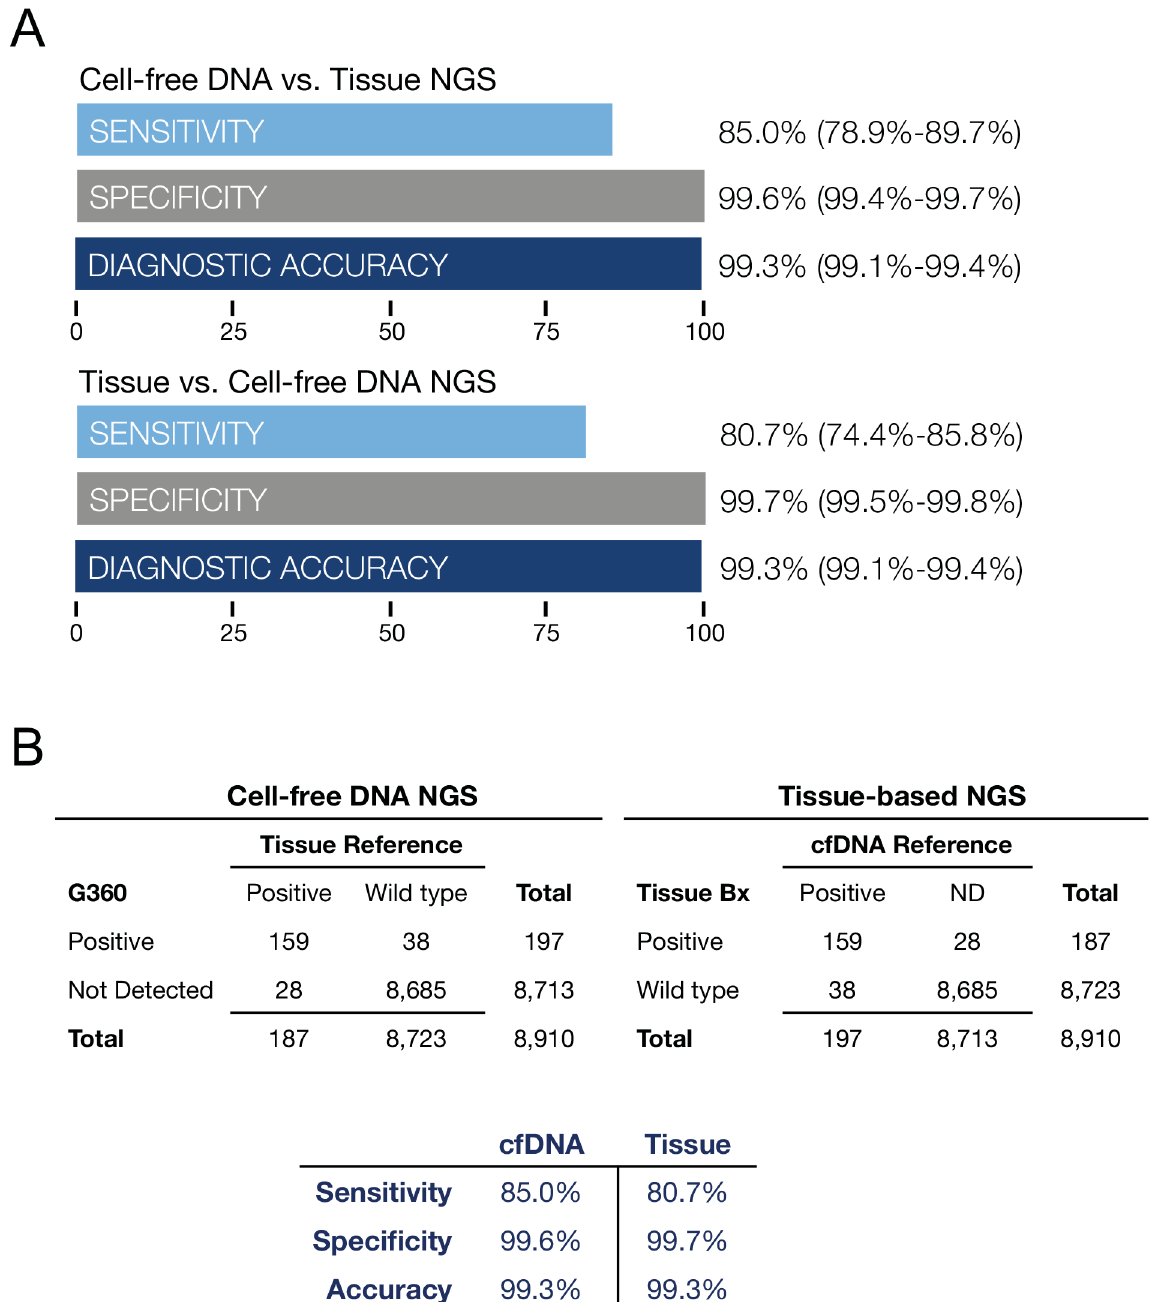
Fig 7. Fig 7A is a comparison of tissue NGS results biopsied at five outside institutions compared to cfDNA sequencing at Guardant Health on 165 paired plasma samples from stage III-IV solid tumor cancer patients. Data summarizes diagnostic test performance for all 54 mutated tumor suppressor and oncogenes. The most commonly mutated genes were ALK, APC, BRAF, CDKN2A, CTNNB1, FBXW7, KRAS, NRAS, PIK3CA, PTEN , and TP53 . Sensitivity, specificity and diagnostic accuracy are shown with 95% confidence intervals.Fig 7B illustrates the two by two contingency tables corresponding to Fig 7A. On the left cfDNA NGS results are compared to tissue-based NGS as the reference standard. On the right tissue- based NGS results are compared to cfDNA findings as the reference standard. All gene mutations found in cfDNA and tissue DNA based on NGS of 54 genes are shown in S2 Table. Both methods demonstrate similarly high sensitivity and near-perfect specificity. For cfDNA, sensitivity is limited by the amount of tumor DNA shed into circulation and for tissue, sensitivity is likely limited by sampling error related to intra-or inter-tumor heterogeneity. The sampling error on tissue samples may be related to sub-sampling of tumor heterogeneity by needle or surgical